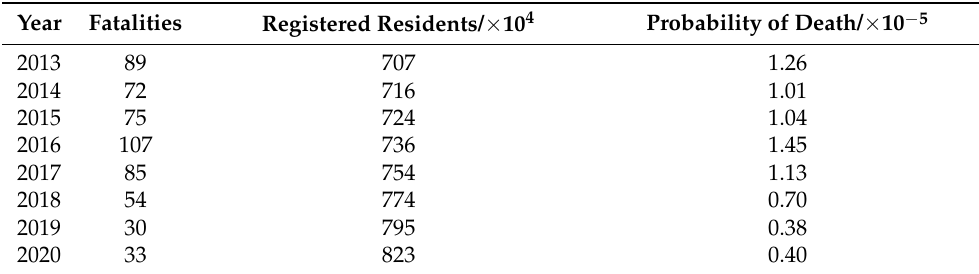
Table 8. Deaths caused by industrial and mining accidents in Hangzhou from 2013 to